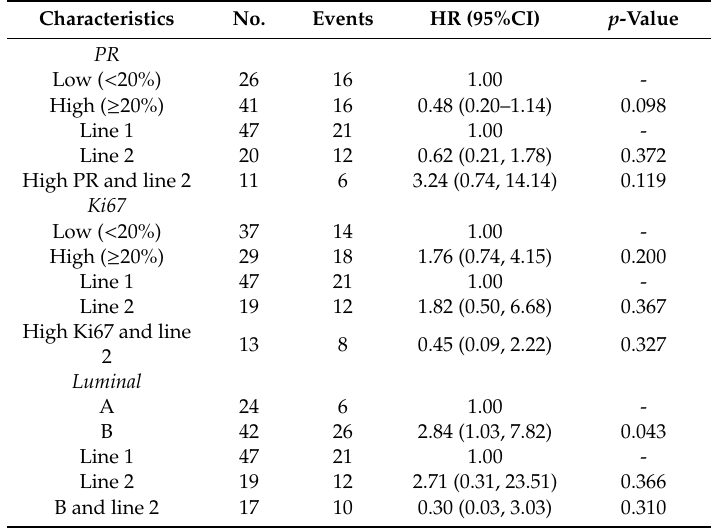
Table 3. Survival analysis for pathological characteristics and their interaction with line of